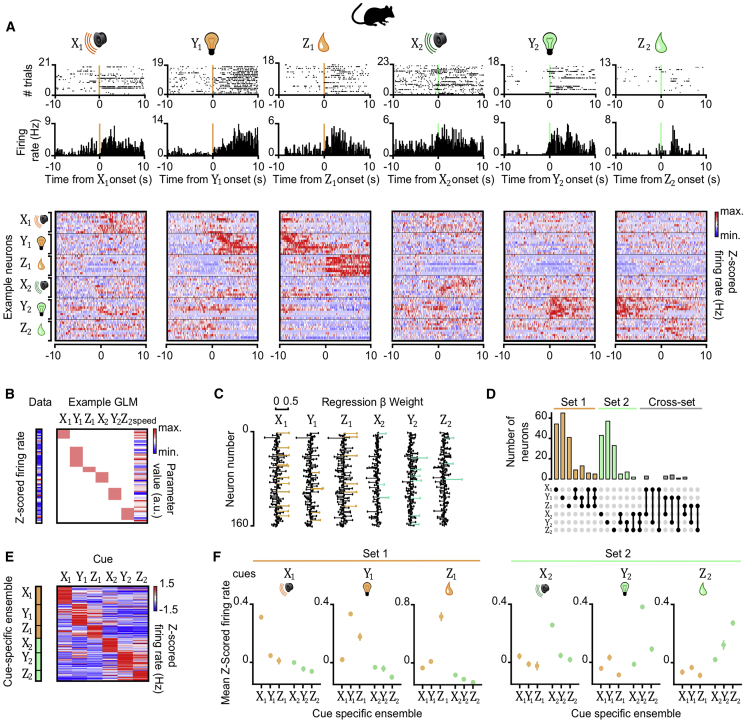
dCA1 Neuronal Representation of Inference Task Cues in Mice(A) Top and middle rows: Raster plots and peri-stimulus time histograms for 6 example neurons, each showing firing response to one of the 6 task cues (Xn, Yn, and Zn) (Figure 1A). Bottom row: heatmap showing the average Z scored firing rate (Hz) of 60 example neurons in response to task cues, ordered according to the preferred cue on the y axis.(B) For each recorded neuron, the average Z scored firing rate across each trial was filtered by the “decision point” (Figure S4) and regressed onto a GLM that modeled all task cues and the mouse’s average speed. GLM for an example neuron is shown.(C) For each cue, the regression weights from all neuron-specific GLMs are shown for an example recording day. Neurons with regression weights more than 2 SD from the group mean were assigned to a cue-specific ensemble and color-coded for visualization (orange, set 1; green, set 2).(D) UpSet plot (Lex et al., 2014) showing the number of neurons within and shared across each cue-specific ensemble. Only a minority of neurons contributed to more than one cue-specific ensemble.(E and F) Average Z scored firing rate of neurons in the Xn,Yn, and Zn ensembles in response to each task cue. (E) For an example recording day, the average response of each neuron allocated to a cue-specific ensemble is shown. (F) Across all recording days, the average response of all neurons in a given cue-specific ensemble is shown (mean ± SEM).See also Table S4.